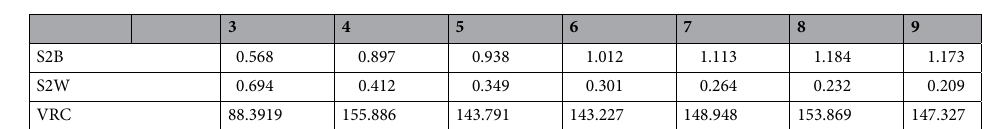
Table 2. Selection of the number of clusters using the Calinski-Harabasz Index (VRC). S2B, between-cluster variance; S2W, within-cluster